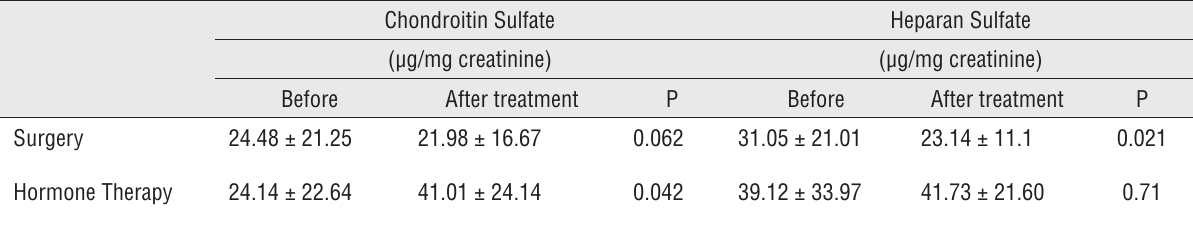
Table 2 - Chondroitin sulfate and heparan sulfate quantified before and after treatment.